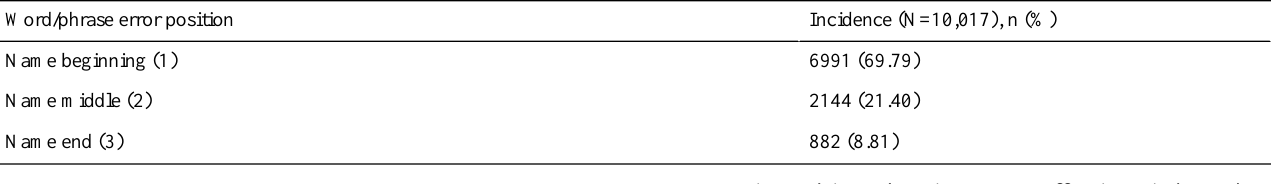
Table 6. Incidence by word/phrase error